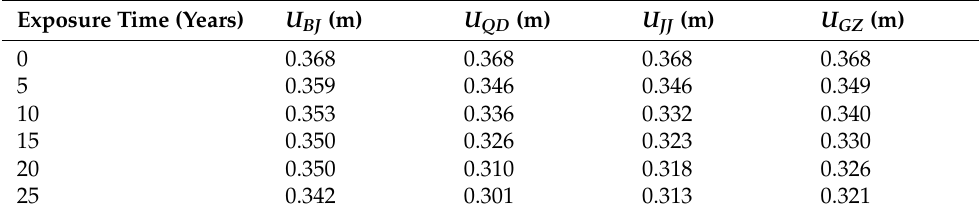
Table 10. Collapsed-tower top displacement statistics at different exposure times in each region.